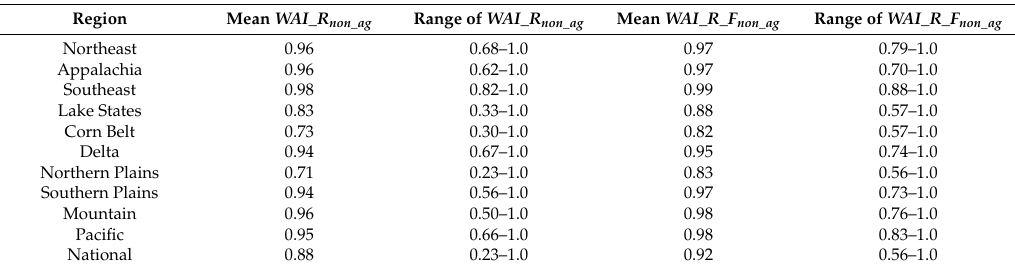
Figure 6. County-level ( a ) mean WAI_R non_ag and ( b ) mean WAI_R_F non_ag . Panel ( a ) shows the fraction of green water resources available for non-agriculture uses if green water meets the crop water demand of total corn, soybeans, and wheat production in 2008. Panel ( b ) shows, when green water consumption of three major crops is accounted for, the fraction of green water resources remaining for non-agriculture uses. Table 3. Regional and national mean WAI_R non_ag and WAI_R_F non_ag with ranges of county-level values (dimensionless fractions). WAI_R non_ag is based on crop water demand of three crops (corn, soybeans, and wheat) and green water resources, and WAI_R_F non_ag is based on green water footprints of the three crops and green water